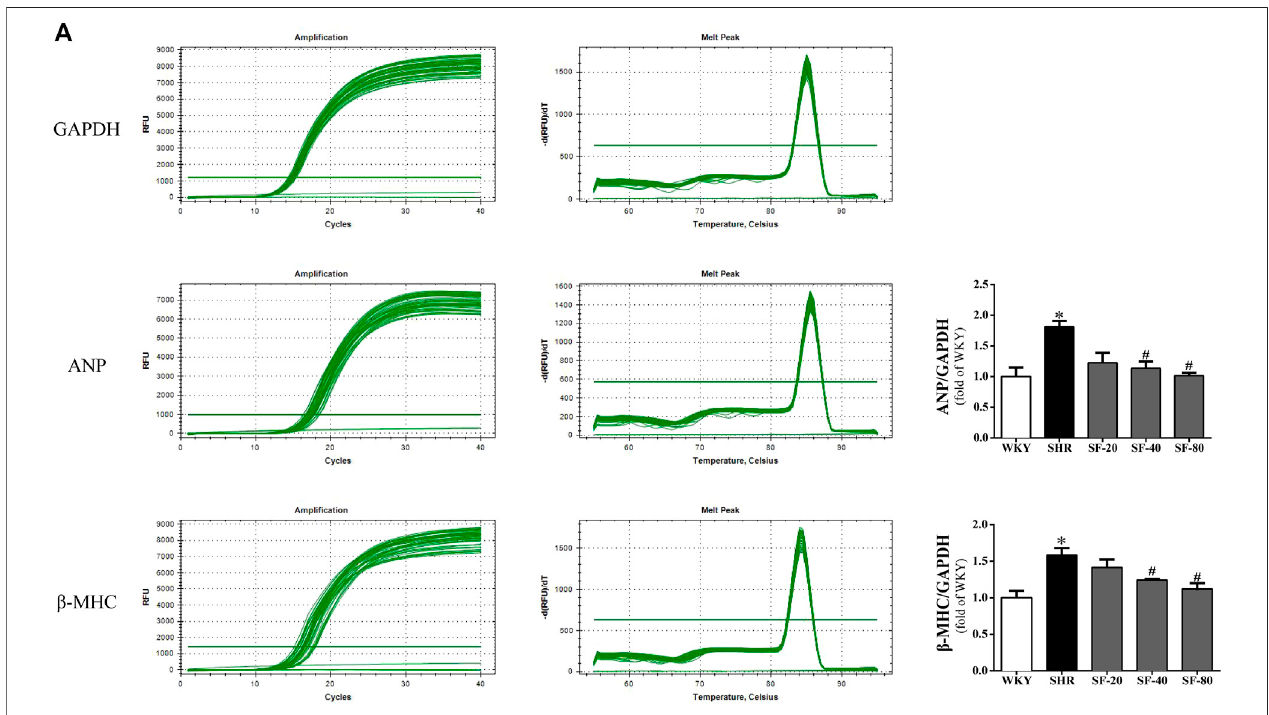
FIGURE 5 | SF downregulates ANP and β -MHC in the myocardial tissue of SHRs. (A) Quantitative analysis of ANP and β -MHC mRNA levels. ( n (cid:1) 5). (B) immunohistochemicalstainingofANP and β -MHC(bar (cid:1) 20 μ m).( n (cid:1) 5). (C) quantitativeanalysisofANP and β -MHC protein levels. ( n (cid:1) 3).ANP and β -MHC mRNAand protein level were signi fi cantly higher in the myocardial tissue of SHRs than WKY rats. SF signi fi cantly downregulated the levels of ANP and β -MHC in the myocardial tissue of SHRs. Data are presented as mean ± SEM. *signi fi cantly different from WKY at p < 0.05; # signi fi cantly different from SHRs at p <